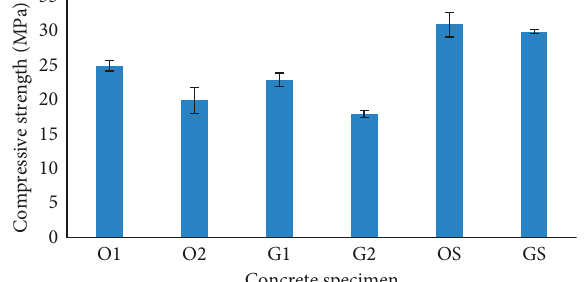
Figure 4: Void volume fraction vs.